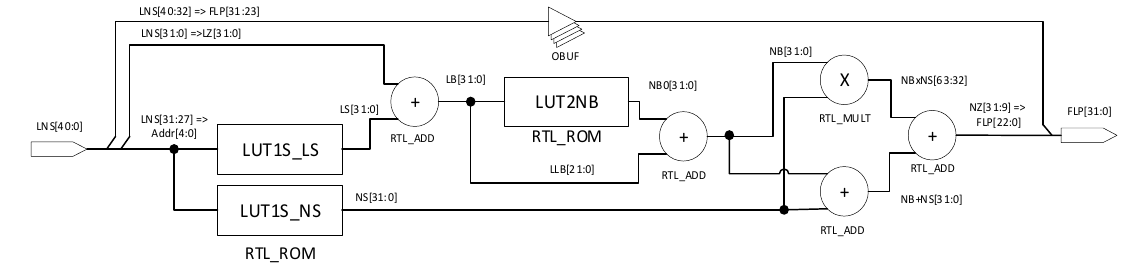
Figure 4. Illustration of the principle of approximating N B using a simple